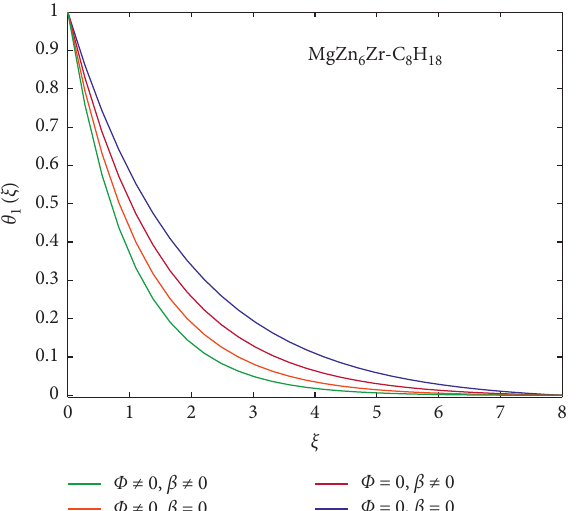
Figure 3: Comparision of temperature distribution in MgZn